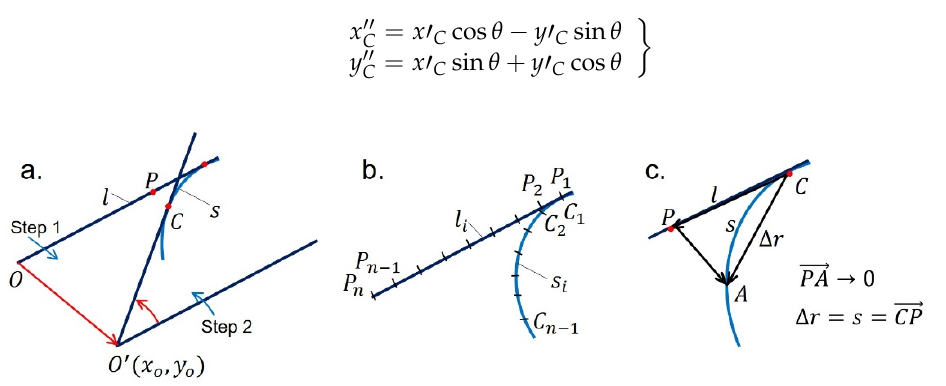
Figure 3. Discretization of pure rolling motion. ( a ) Plane motion of the rigid body with non-pure rolling. ( b ) Discretization of the pure rolling motion. ( c ) Differential analysis.